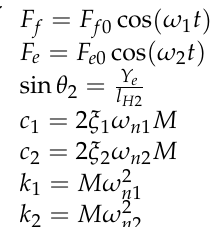
Figure 9. Equivalent model of hybrid biaxial fatigue testing device.